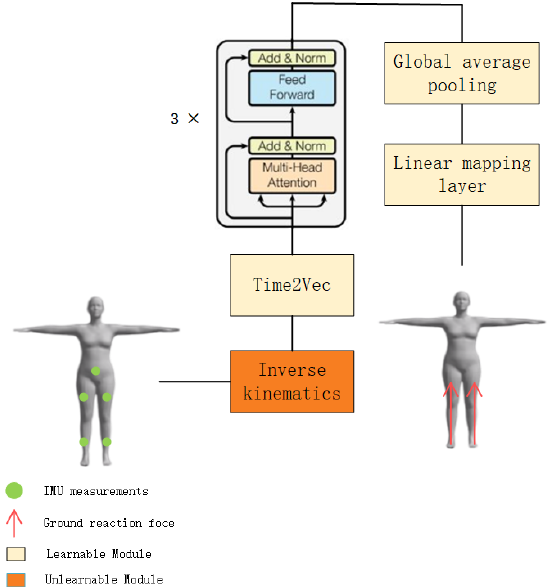
Figure 3. Model framework. The neural network used in this paper contains a temporal embedding layer, three transformer encoders, and a linear layer. The input is the IMU measurements, and the output is the corresponding vGRF.